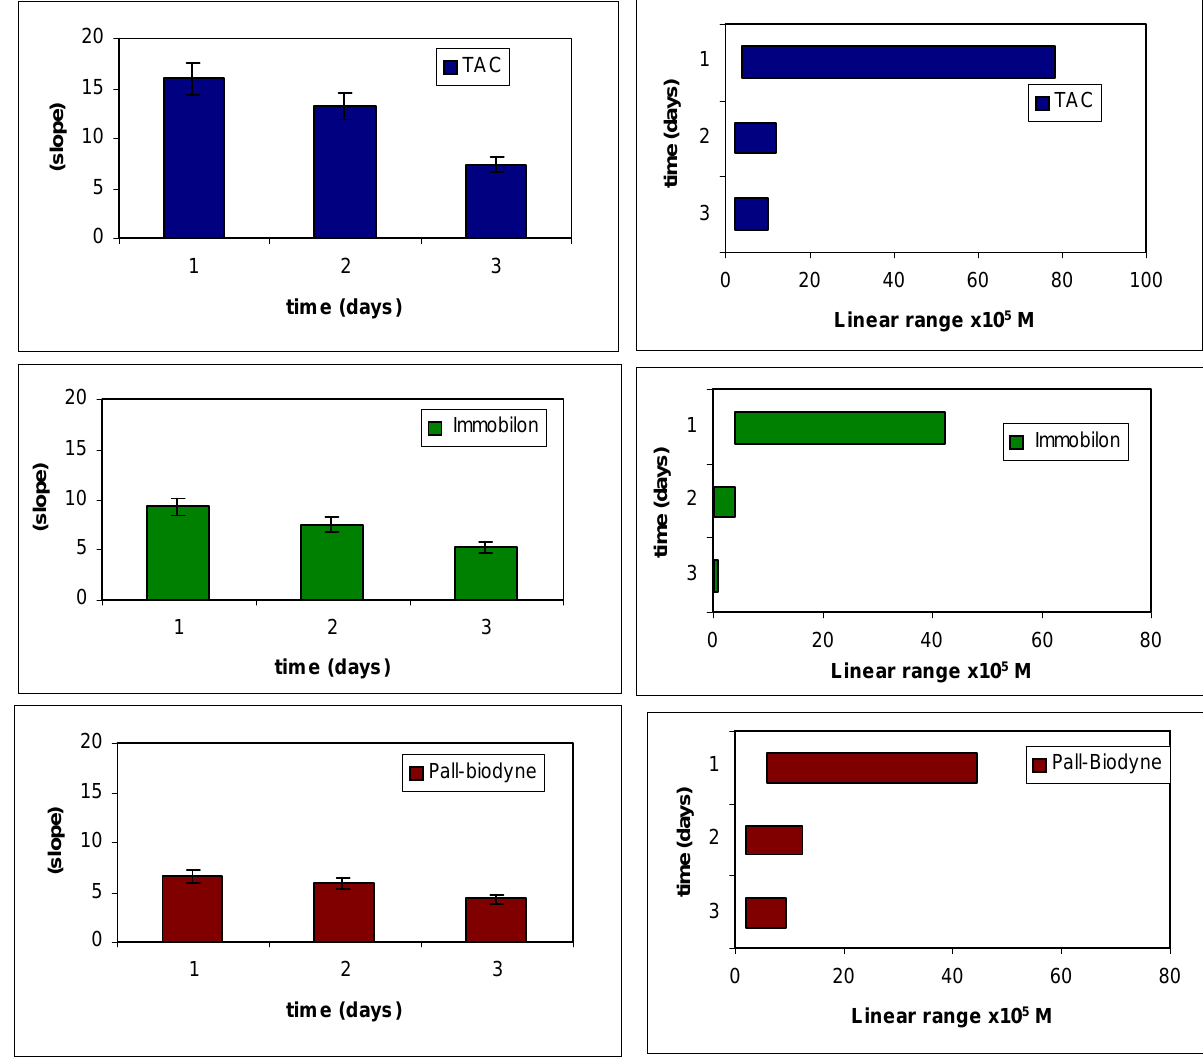
Figure 4. Optimization (slope and linear range during lifetime) of the membrane binding tyrosinase enzyme using three different immobilization methods, to be used for the immunoglobulin G measurement by the new